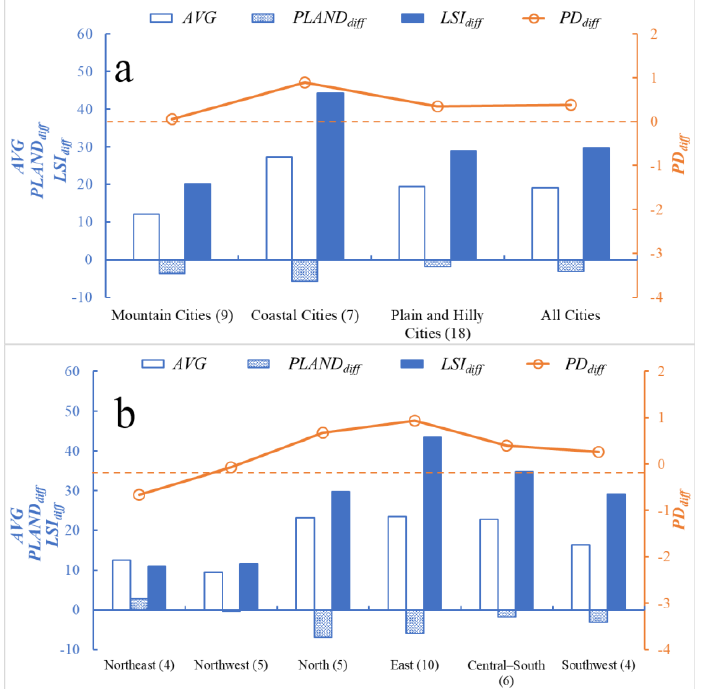
Figure 4. 𝑈𝐵𝐴𝐸𝐼𝑠 for different ( a ) topographies and ( b ) regions. Numbers in parentheses on the x-axes are the numbers of cities. Dashed lines show zero values of PD diff .